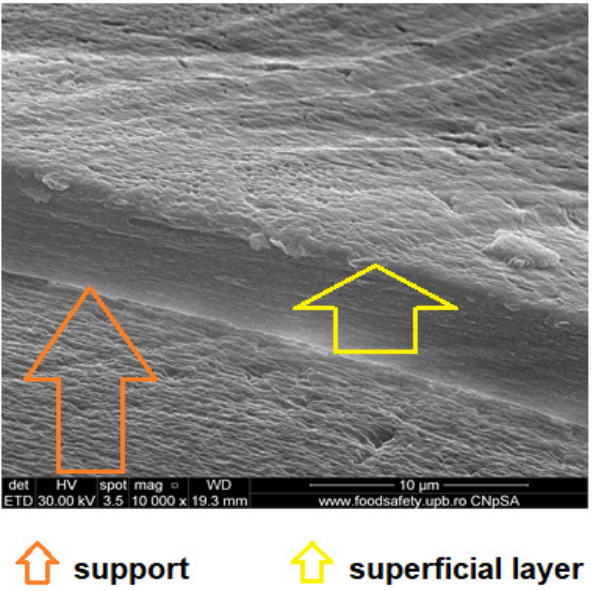
Figure 12. Detail of the superficial layer from the cellulose derivatives on the polypropylene hollow fiber. Figure 13.